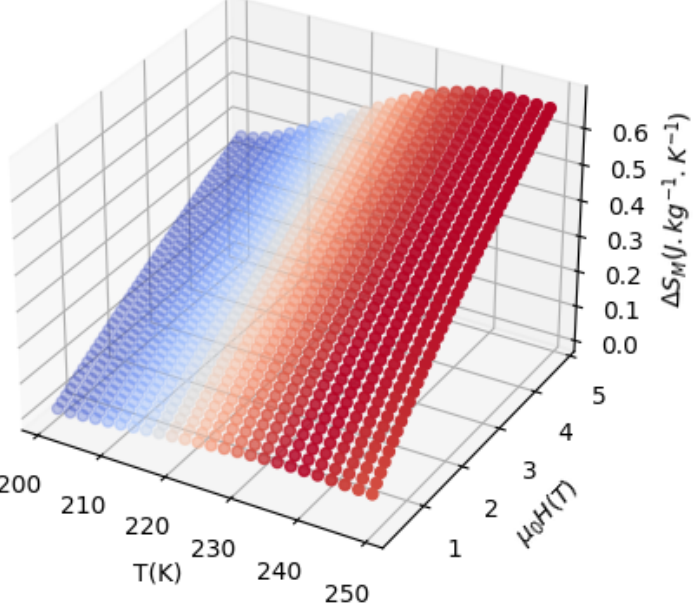
Figure 13. Magnetic entropy change vs. temperature for and SmNi 2.2 Fe 0.8 under several mag- netic